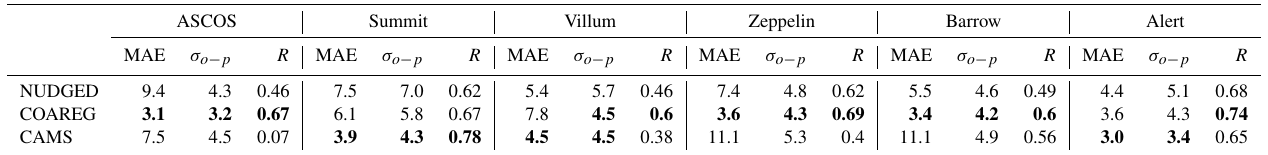
Table 2. MAE (ppb), σ o − p (ppb) and Pearson R correlation coefficient ( R ) (–) for the NUDGED and COAREG runs and CAMS reanalysis data at the ASCOS, Summit, Villum, Zeppelin, Barrow and Alert observational sites. The lowest model error and highest correlation have been made bold for every